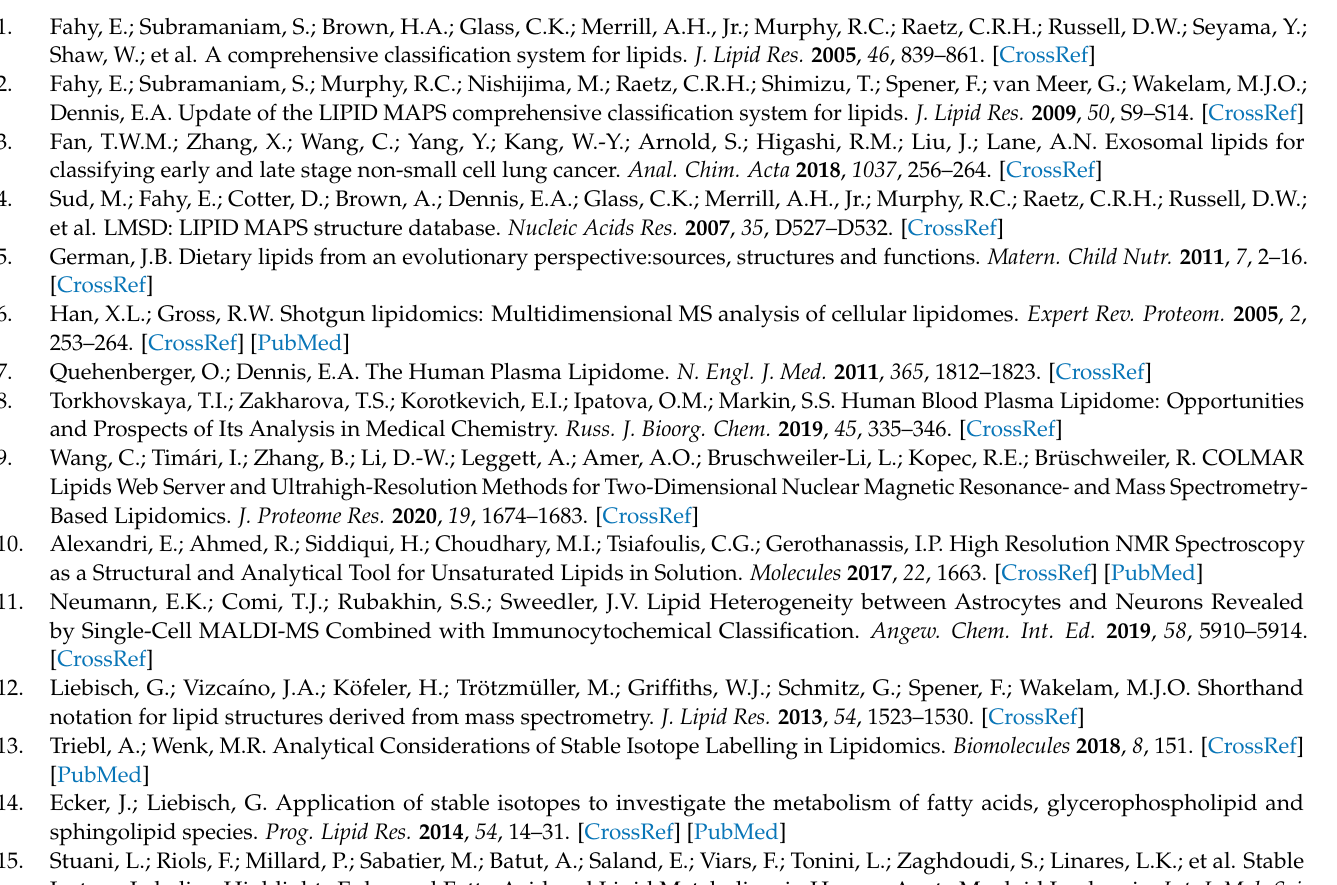
Figure S1: Common major lipid classes, Figure S2: Comparison of 1D PRESAT spectra of WT or TRAP-1 KO cell extracts; Figure S3: Comparison of 1D 13 C HSQC spectra of WT UMUC3 or PC3 cell extracts; Figure S4: Carbon 1D spectrum of the lipid extract from PC3 KO cell